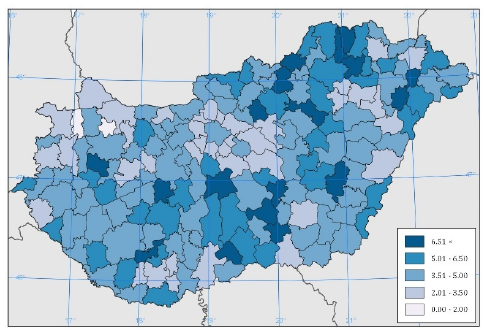
Data source : K-Monitor Figure 9: Rate of deaths among confirmed COVID-19 cases (%) at the micro-regional level of Hungary (LAU 1) between 4 March 2020 and 14 February 2021